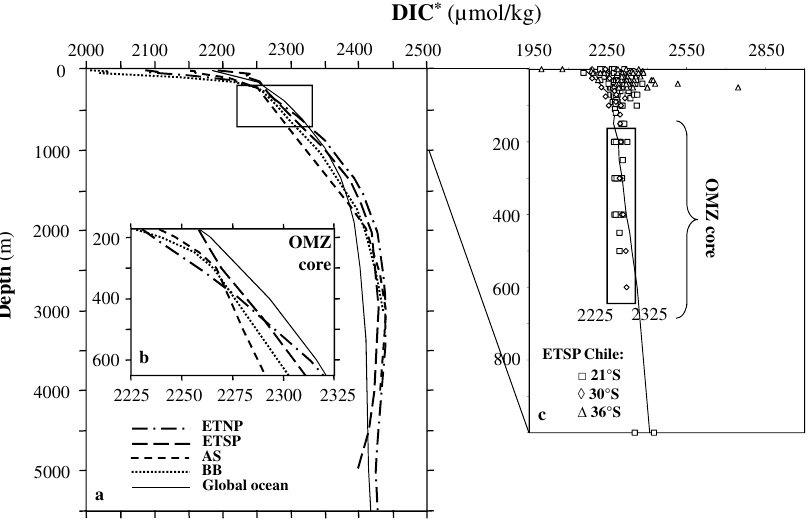
Fig. 3. Vertical profiles of DIC ∗ (= DIC + 0.69 O 2 : cf. Methodology and the comments provided for Eq. 1) for the main OMZs from GLODAP and WOA2005 databases on 0–5500m (a) , with a zoom in the layer intercepting the core of all considered OMZs (b) , and from all stations sampled in the OMZ off Chile in 2000–2002 (c) . Continuous profile in ( a and c ) corresponds to a mean profile for the global ocean and for the oxygenated Pacific out of the OMZ, respectively. Rectangles in ( a and b ) indicate the OMZ core. For ETNP, ETSP, AS and BB, same abbreviations than in Table 1